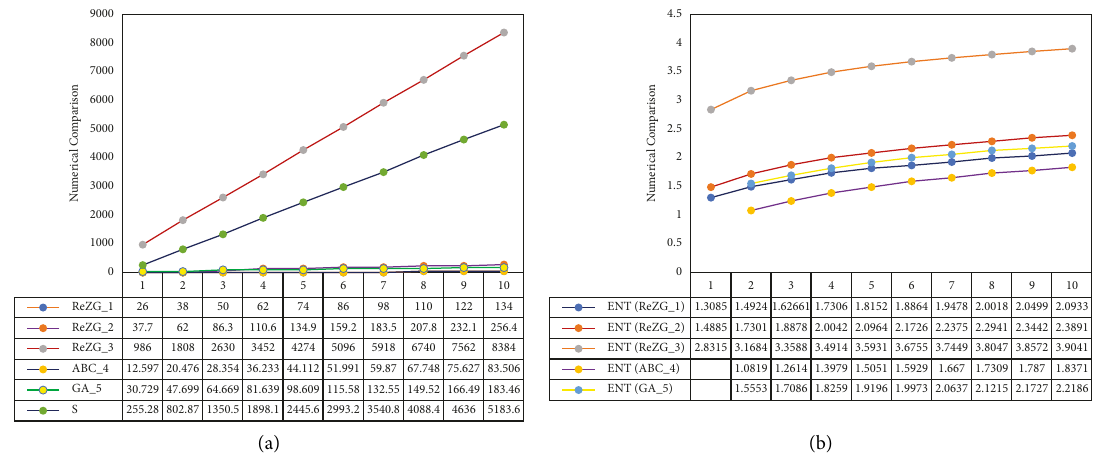
K S n ) . (b) Comparison of (